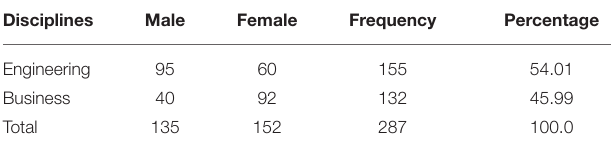
TABLE 1 | Descriptive analysis of students who participated in the